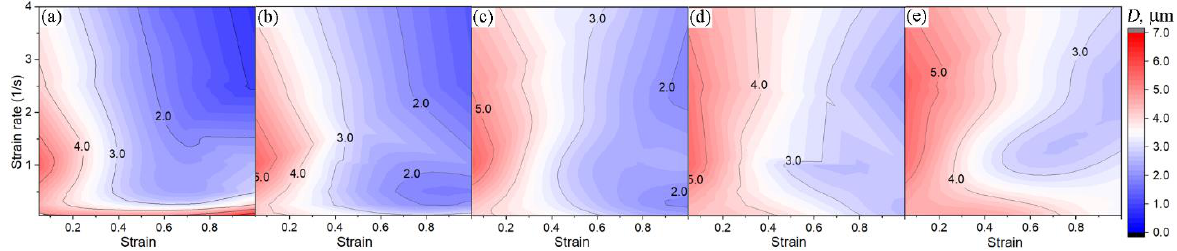
Figure 14. The effect of strain and strain rate on the average grain diameter D depending on temperature, ◦ C: ( a ) 300, ( b ) 350, ( c ) 400, ( d ) 450, and ( e ) 500. The dependences have been obtained from neural network predictions.